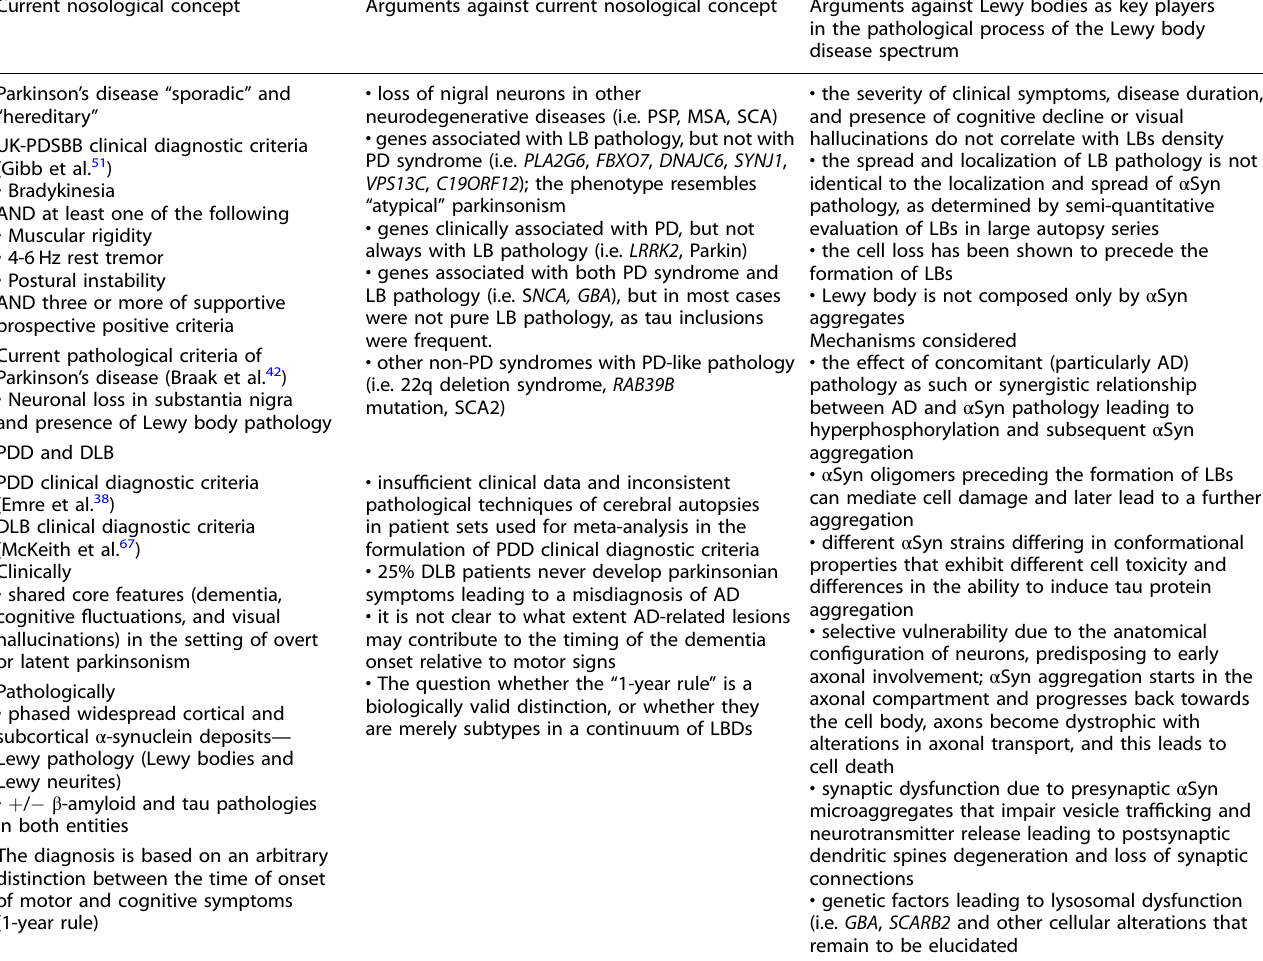
Table 2. Arguments against the current concept of Lewy body diseases. Current nosological concept Arguments against current nosological concept Arguments against Lewy bodies as key players